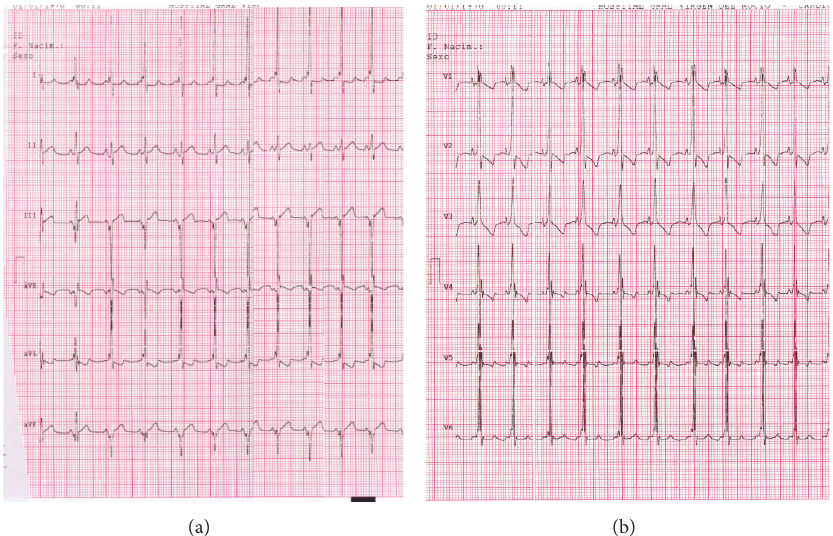
F 3: Neonatal electrocardiogram showing biventricular